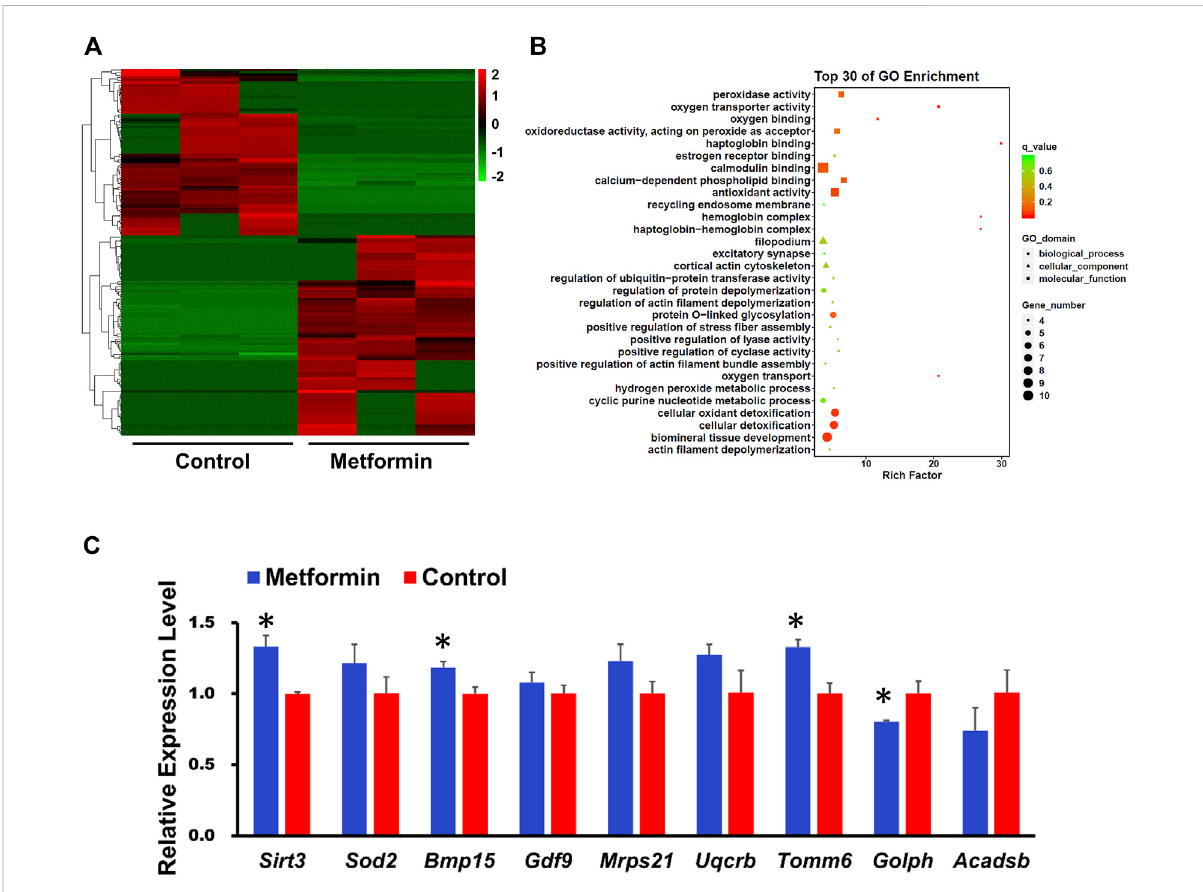
FIGURE 3 Whole-genome transcription analysis of oocyte after IVM from aged mice with or without metformin treatment. (A) Heatmap illustration showing differentially expressed transcripts in M Ⅱ stage oocytes after IVM with or without metformin treatment. (B) GO analysis of the top of 30differentiallyexpressedgenes(DEGs)showsthebiologicalprocessesaffectedbythealteredmRNAexpressionbycomparingthegeneexpression in M Ⅱ stage oocytes after IVM with or without metformin treatment. (C) qPCR results shows the expression levels of the indicated transcripts in control and metformin-treated oocytes. Data are means ± SD of at least three independent experiments. Means ± SD, * p < 0.05 vs. control as calculated by two-tailed unpaired Student ’ s